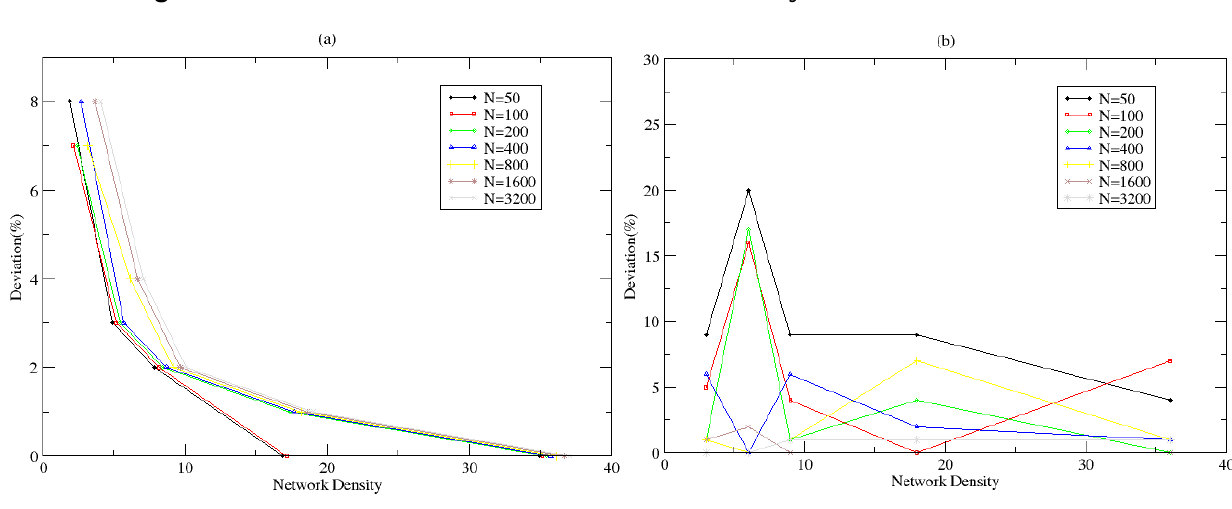
Figure 11. Deviation in the estimation of the (a) density and (b) size of the WSN.